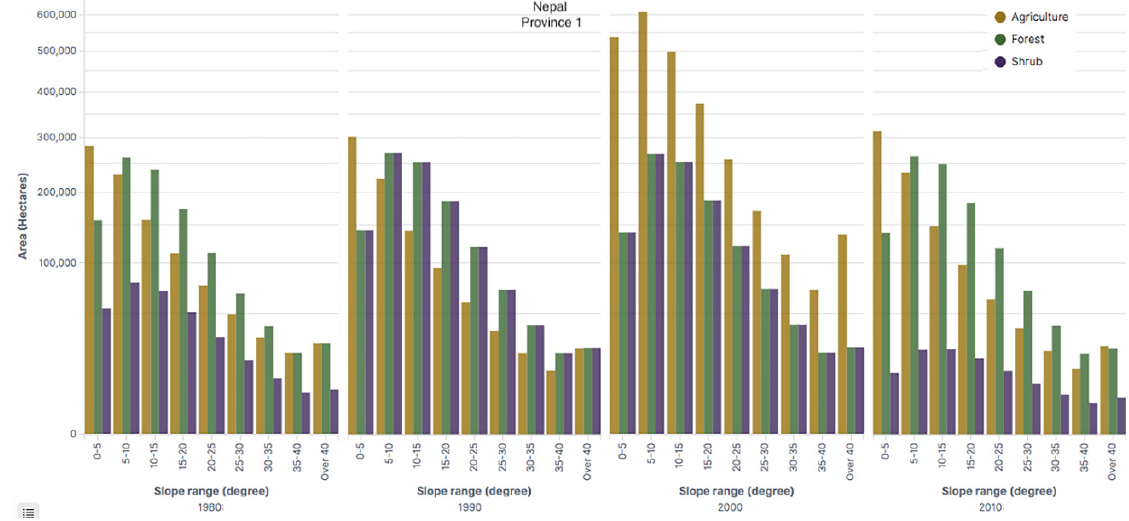
Figure 12. Province 1: forest, shrubland, and agricultural areas of Nepal by 9 elevation classes for 1980, 1990, 2000, and 2010. Table 7. Province 1: land use as a percentage of total area of forest, shrubland, and agriculture for 1980, 1990. 2000, and 2010 for entire Nepal. ((Individual land-use area for a slope class/sum of forest + shrubland + agriculture) * 100).